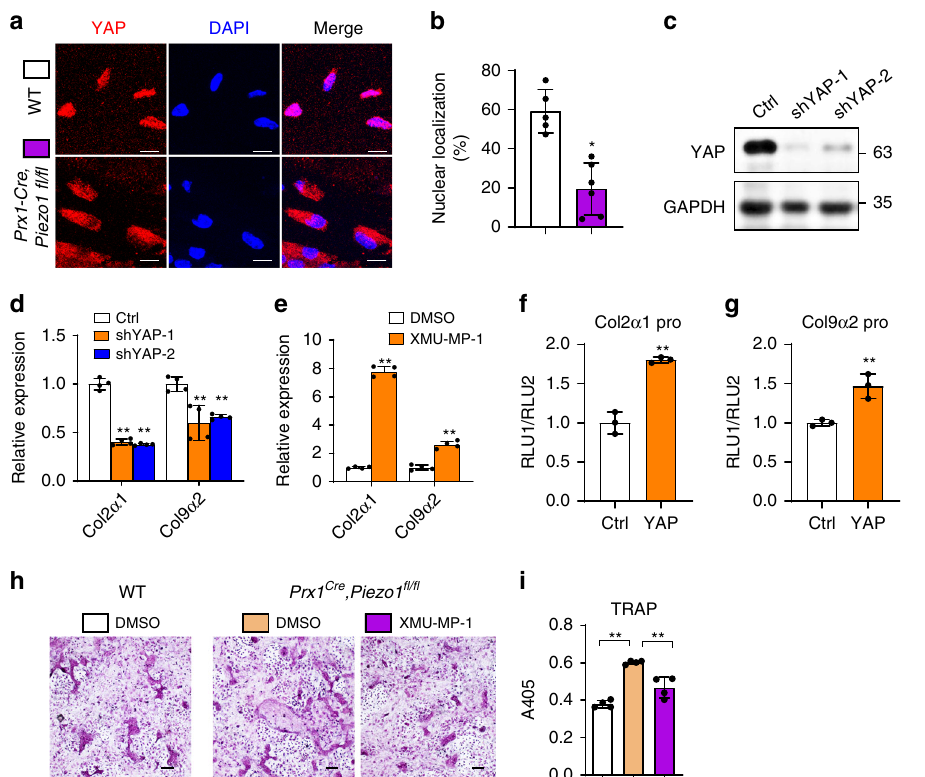
Fig. 6 PIEZO1 promoted collagen expression through YAP nuclear localization. a Immuno fl uorescence assay of YAP in the cortical bones of WT and Prx1 Cre , Piezo1 fl / fl mice. Scale bar = 10 μ m. b Quanti fi cation of YAP nuclear localization percentage in WT and Prx1 Cre , Piezo1 fl / fl mice. * P < 0.05. Two-tailed Student ’ s t test. Data are mean ± SD, n ≥ 5. c , d YAP expression by western blot ( c ) and indicated gene expression analysis ( d ) in the C3H10 cells infected with shControl and shYAP lenti-virus. e Indicated gene expression analysis in the C3H10 cells treated with DMSO or XMU-MP-1 (10 μ m) for 24 h. f , g Luciferase assays showed that YAP could activate Col2 α 1 ( f ) and Col9 α 2 ( g ) promoters in the C3H10 cells. h , i Osteoclastogenesis by OB-OC co-culture in vitro using BMSCs-derived osteoblasts from WT and Prx1 Cre , Piezo1 fl / fl mice, the co-culture system was treated with DMSO or XMU-MP-1 (0.2 μ m), respectively. h TRAP staining of the osteoclasts in the co-culture system. Scale bar = 100 μ m. i Co-culture supernatants were measured for TRAP activity via colorimetric readout (A405). * P < 0.05; ** P < 0.01. Ordinary one-way ANOVA. Data are mean ± SD, n = 4. Source data are provided in the Source Data